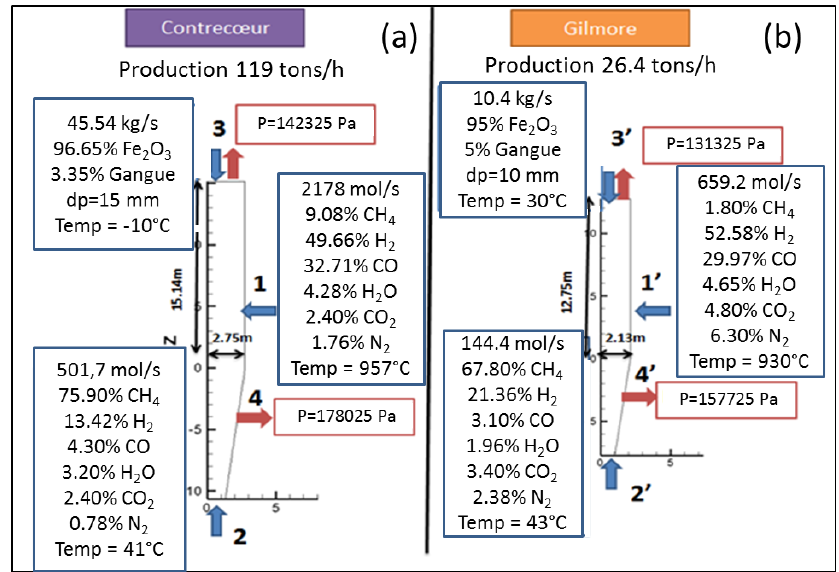
Figure A2. Input conditions of Contrecoeur ( a ) and Gilmore ( b ) plants.